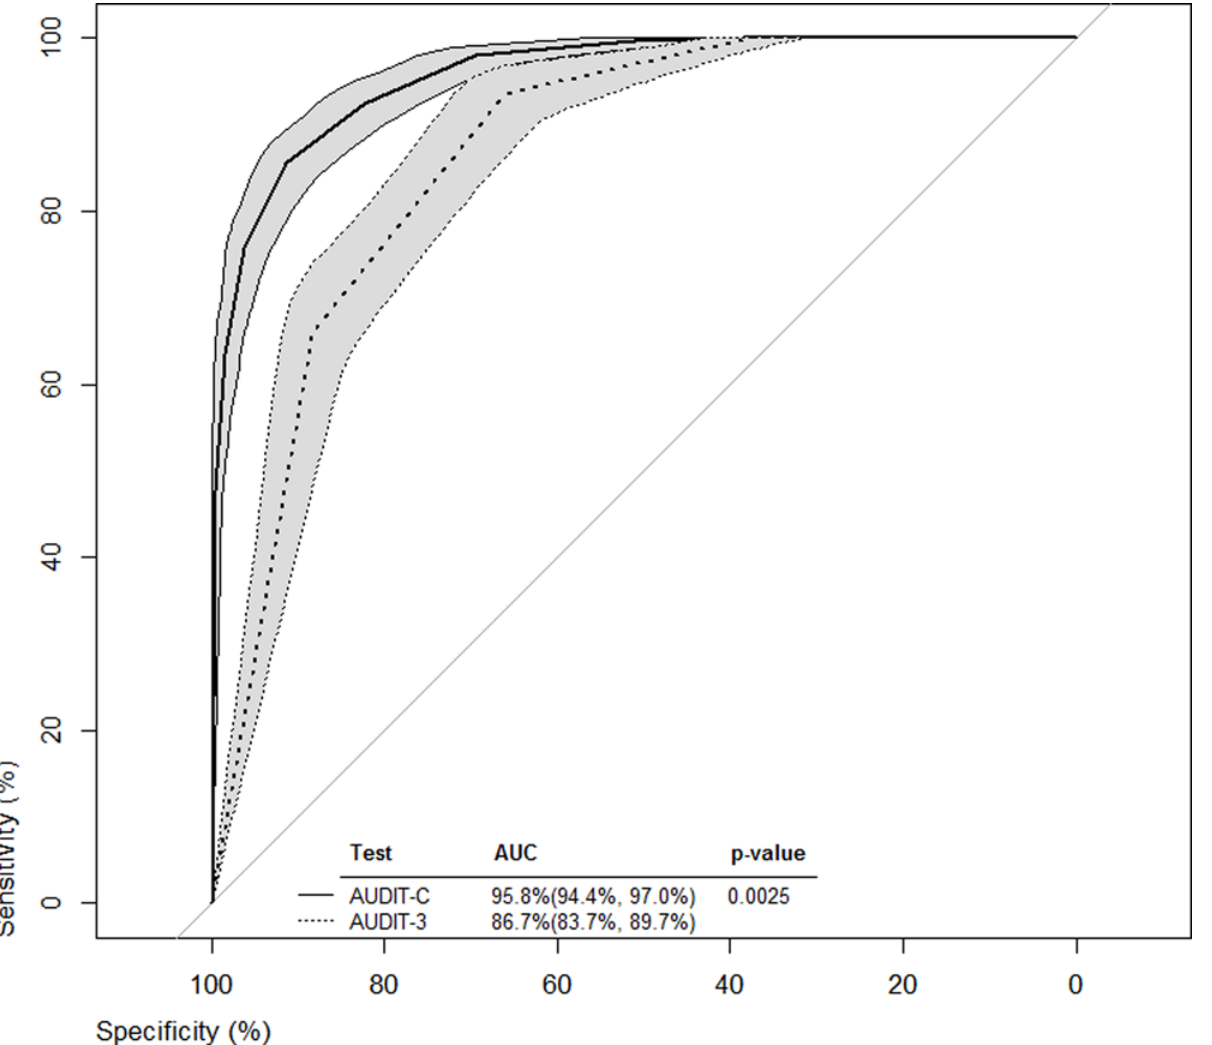
Fig 1. ROC curves for the overall sample from all cut-off values for both AUDIT-C and